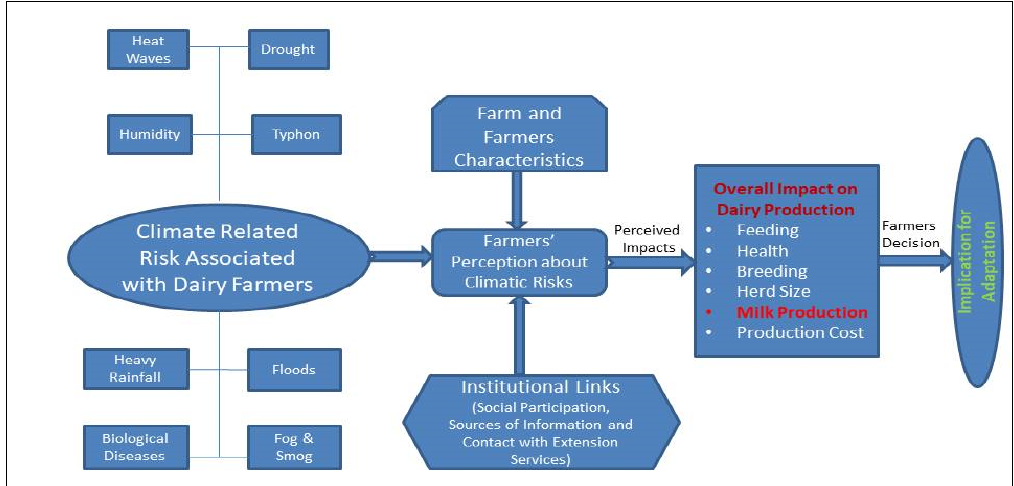
Figure 1. Dairy farming context under climatic risks.